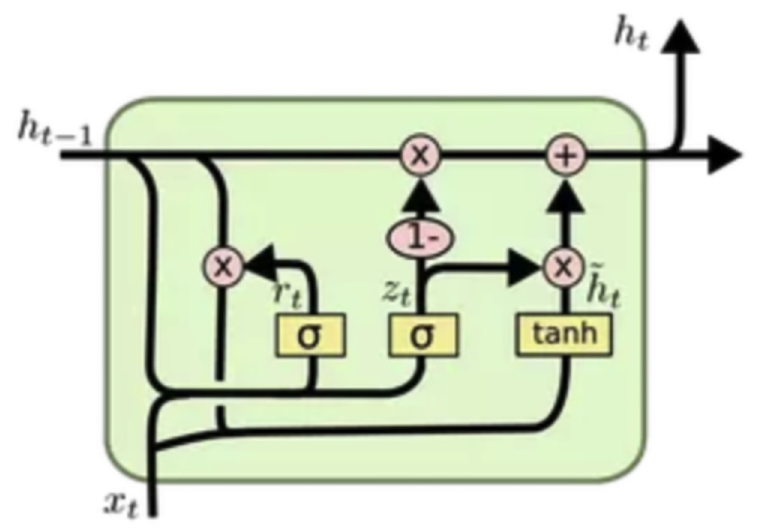
Fig 3. Architecture of a GRU unit